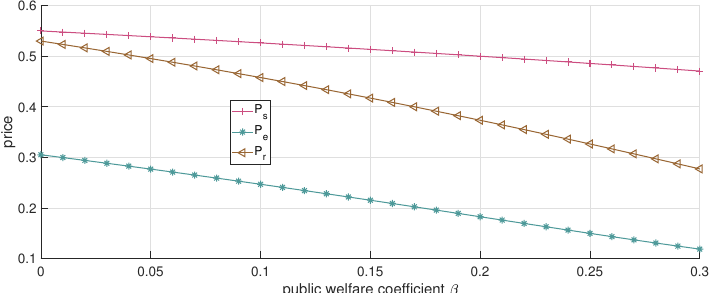
Figure 5. The impact of changes in β on service price (dual-channel strategy p 0 =